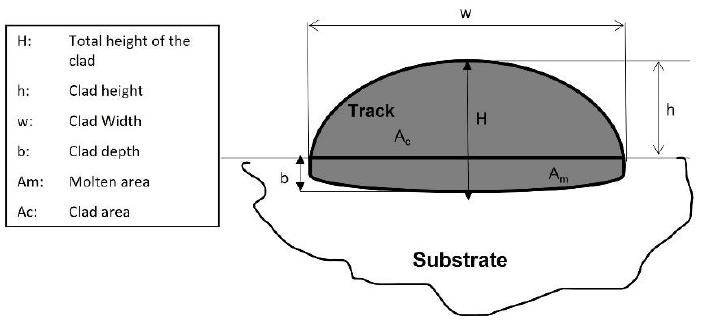
Figure 2. Scheme of the cross-section of a track and measured geometrical features.